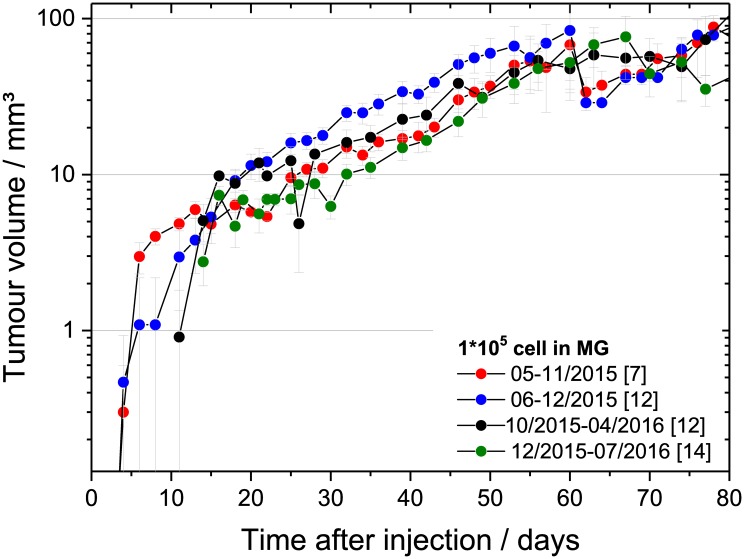
Temporal stability of LN229 growth curves.Average growth curves of LN229 tumours measured after inoculation of 1*105 cells in MG for four temporally different cohorts. The corresponding numbers of animals per cohort are given brackets; the error bars represent the SEM.